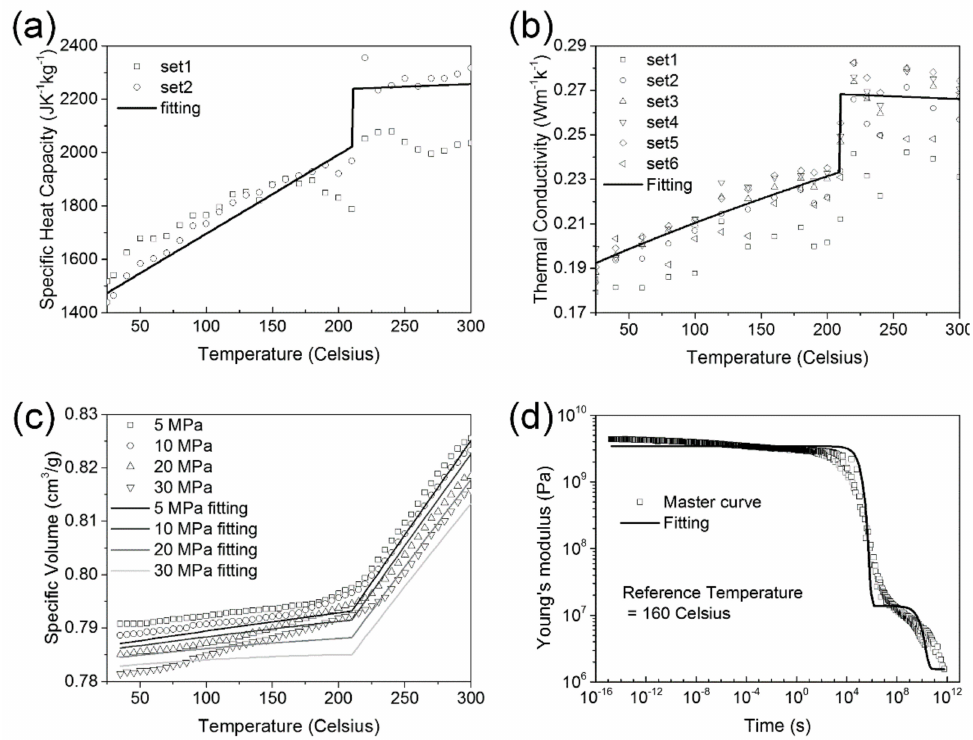
Figure 1. Material properties. ( a ) Specific heat capacity; ( b ) thermal conductivity; ( c ) specific volume; and ( d ) Young’s